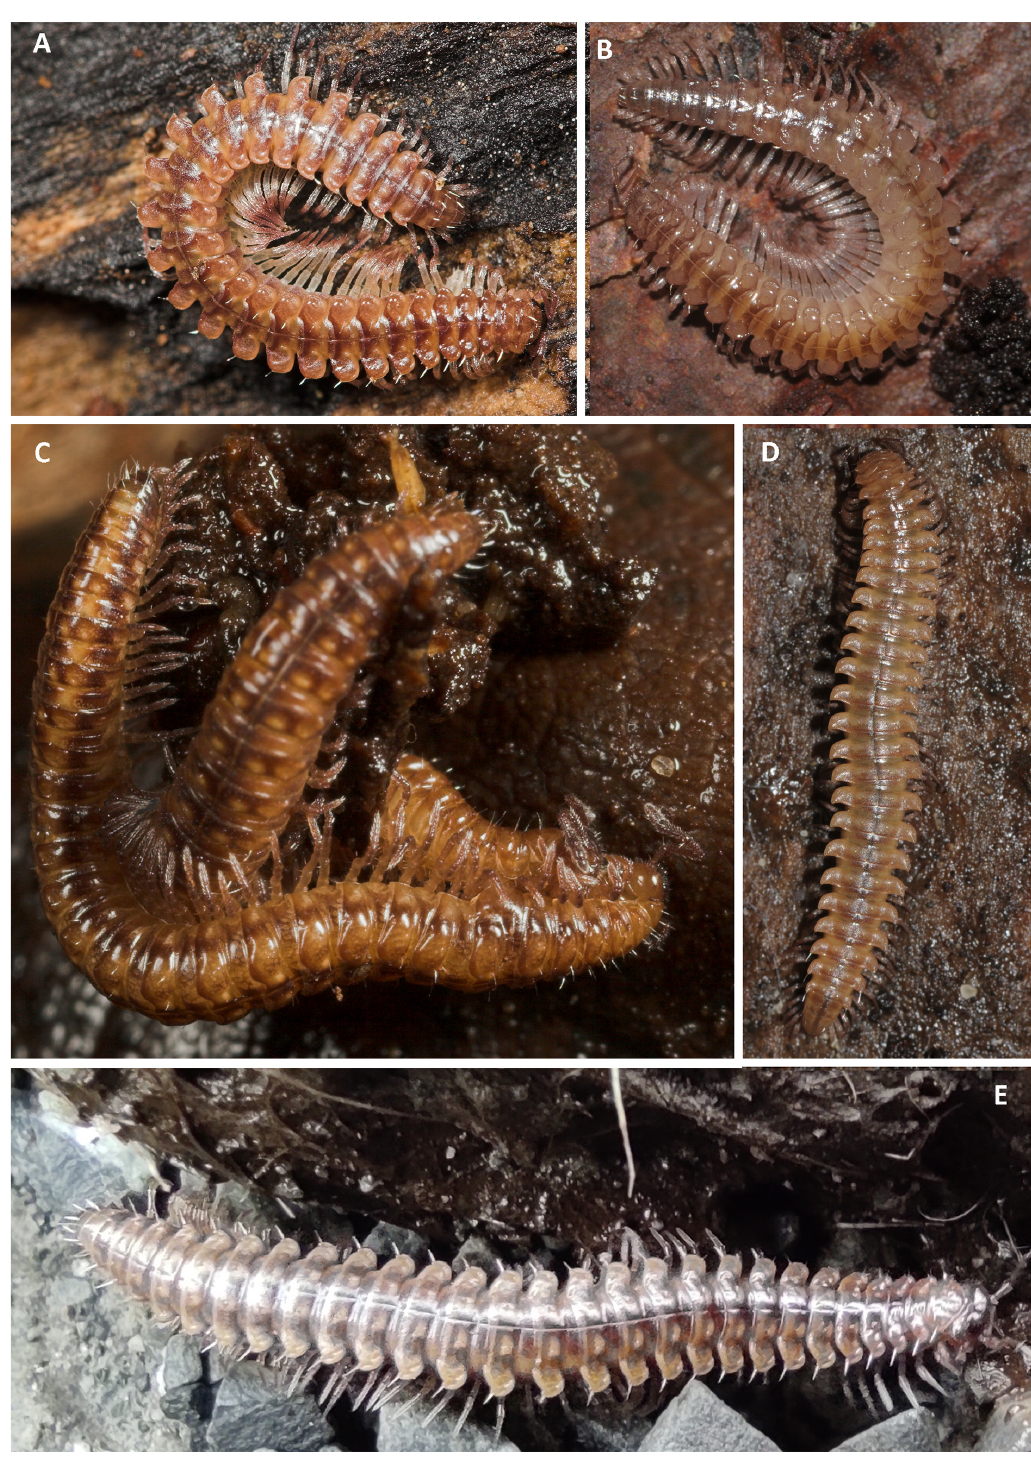
Fig. 1. A selection of European species of Chordeumatida C.L. Koch, 1847, family Craspedosomatidae Gray, 1843. A . Nanogona polydesmoides (Leach, 1814). B . Rhymogona verhoeffi (Bigler,